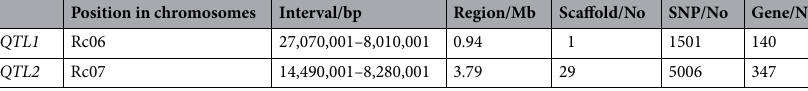
Table 1. Details of two QTL associated with plant height.